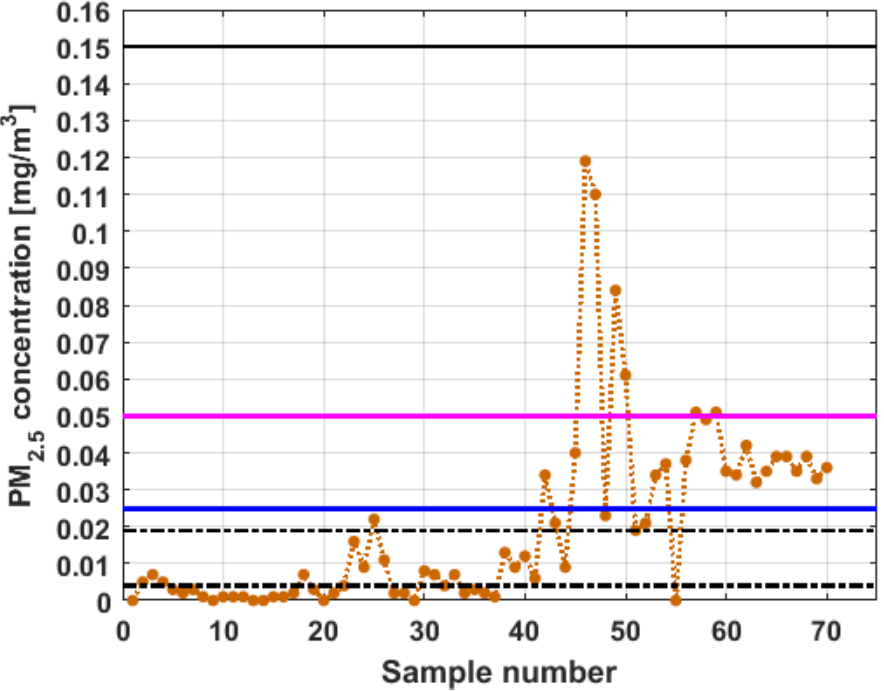
Figure 14. Observations of variable 𝑌 1 , together with the 95% nonparametric confidence interval for the median (shown with dashed black lines) and the limits that define the categories of the level of air pollution by PM 2.5 (Desirable level: Blue line; Acceptable level: Magenta line; Caution level: Black line).